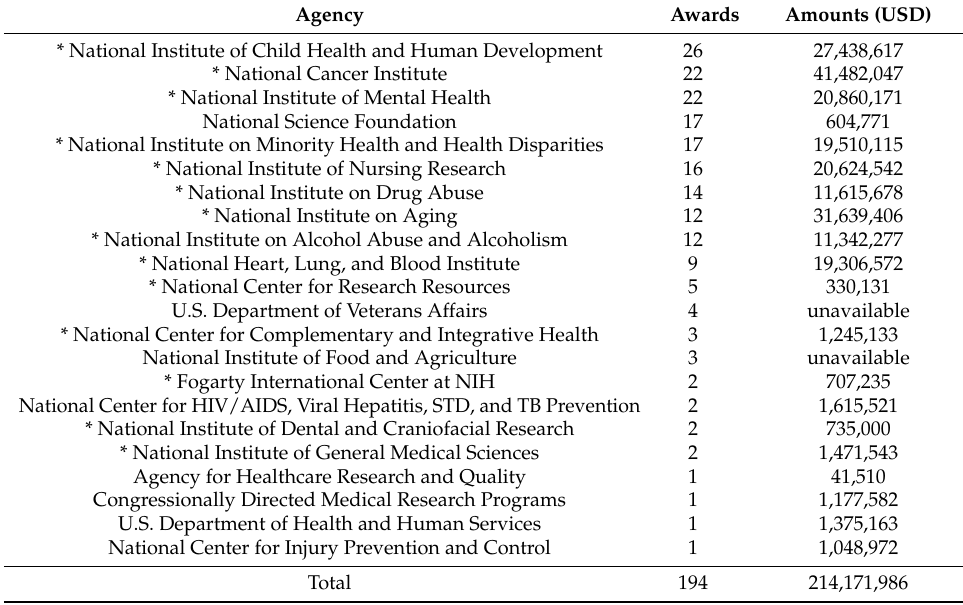
Table 2. Number of grant awards by federal